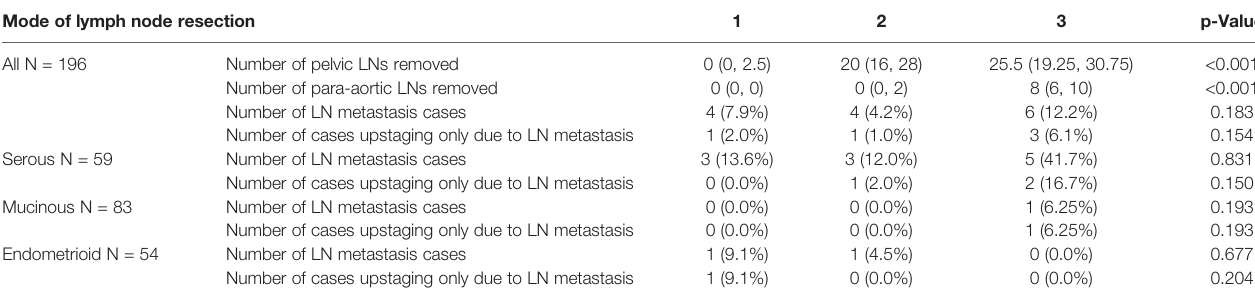
TABLE 2 | LN removed number, LN+ detection rate, and upstaging only due to LN metastasis among three LN dissection groups in all subgroups and pathological subgroups. Mode of lymph node